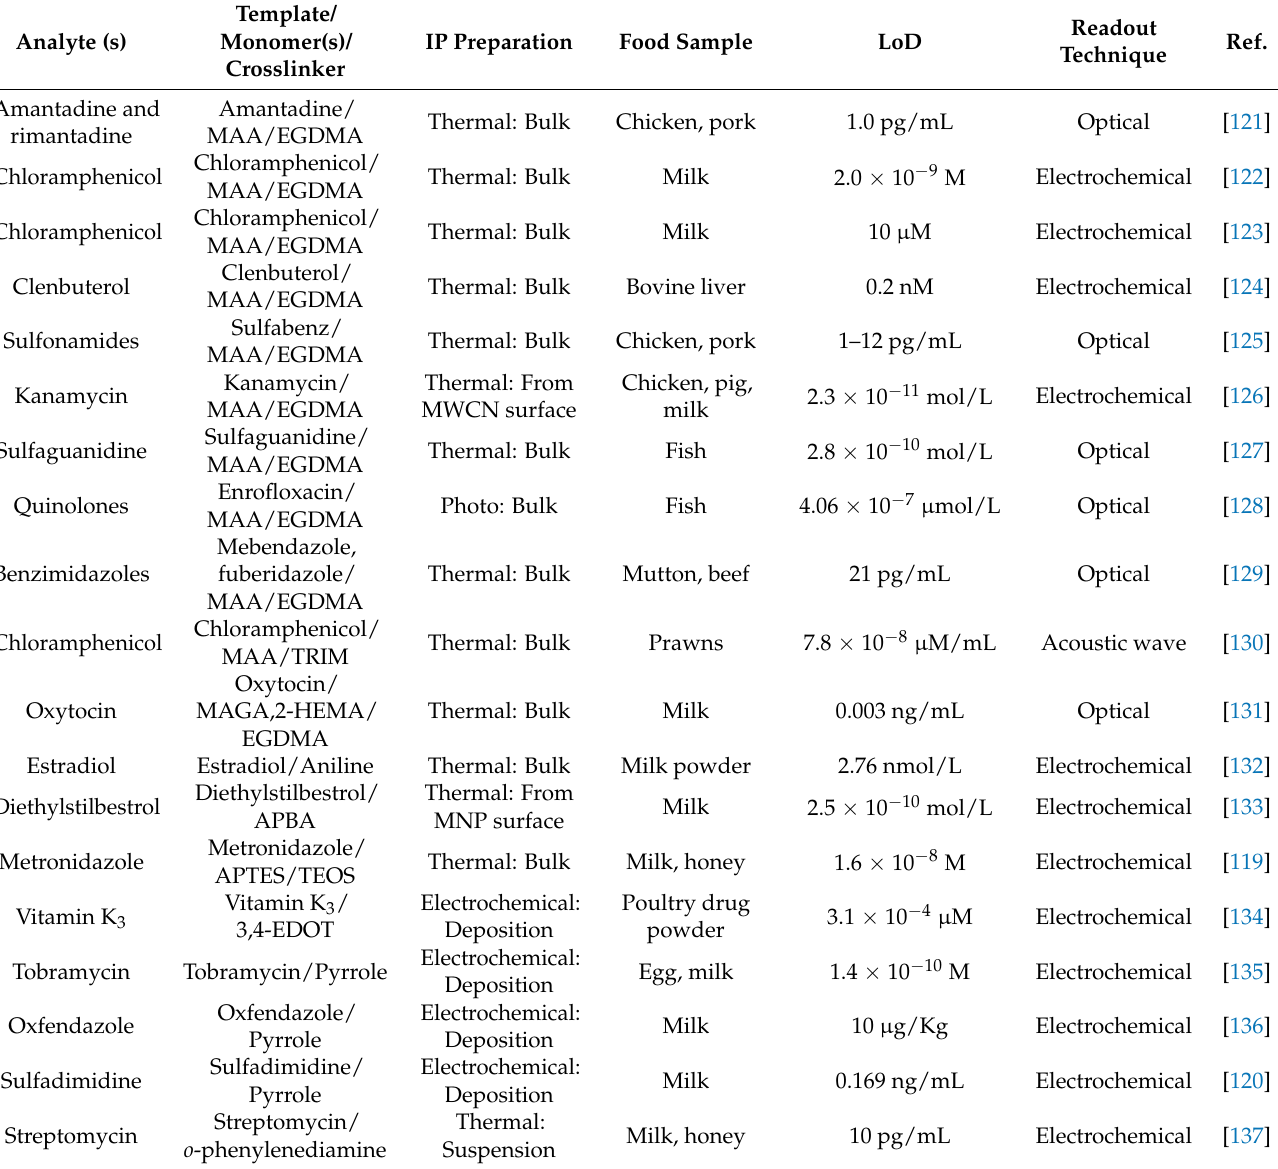
Table 2. Summary of recent publications for the recognition of drugs using IPs in food